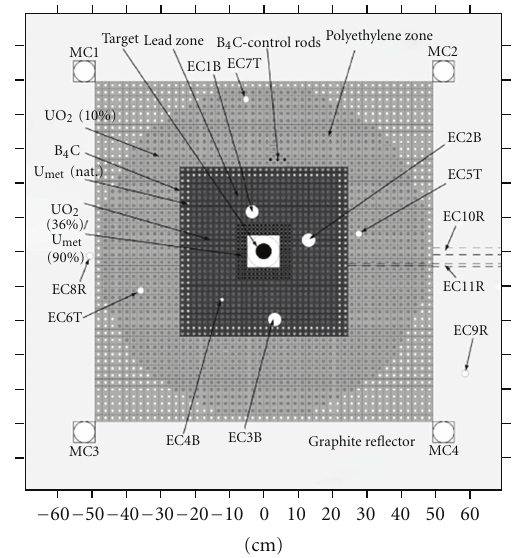
Figure 3: General configuration of the YALINA-Booster